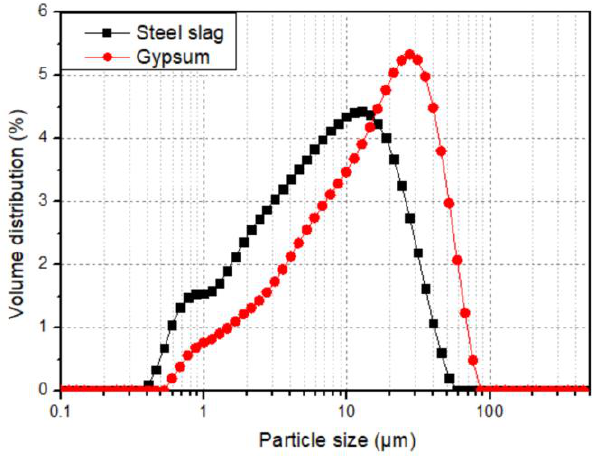
Figure 3. Particle-size distributions of the steel slag powder and gypsum.